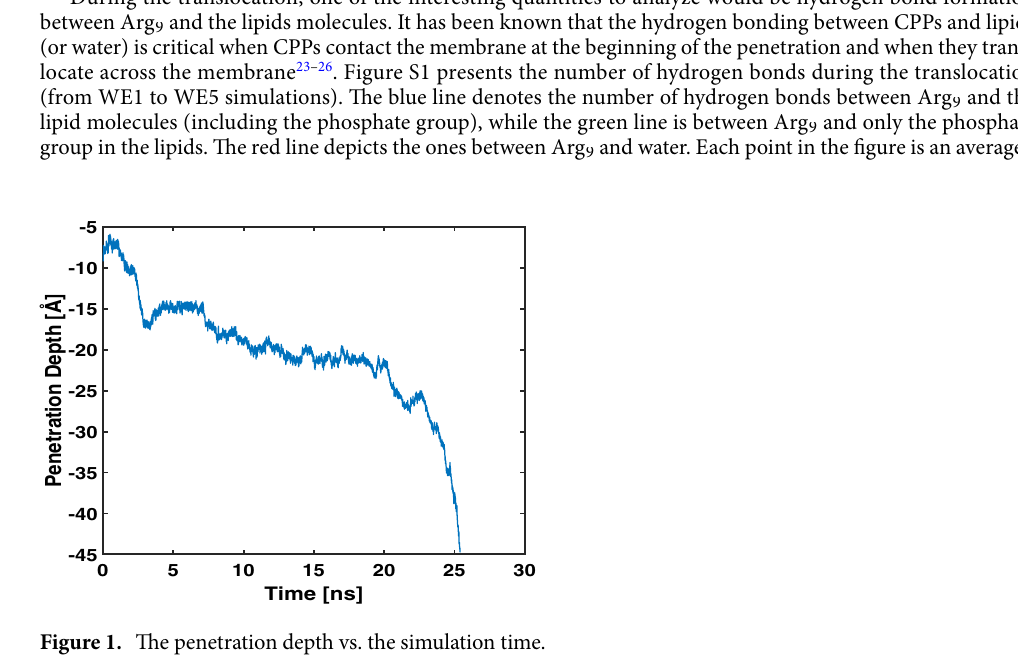
Figure 1. The penetration depth vs. the simulation